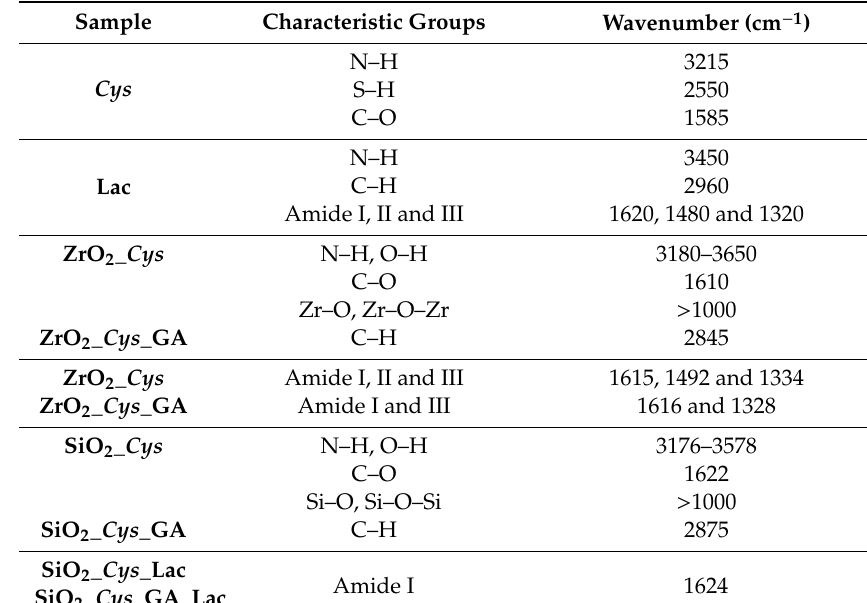
Figure 2. FTIR spectra of samples before ( a , c ) and after ( b , d ) immobilization of laccase. Table 3. Characteristic groups present in cysteine, laccase, and samples before and after immobilization of laccase.